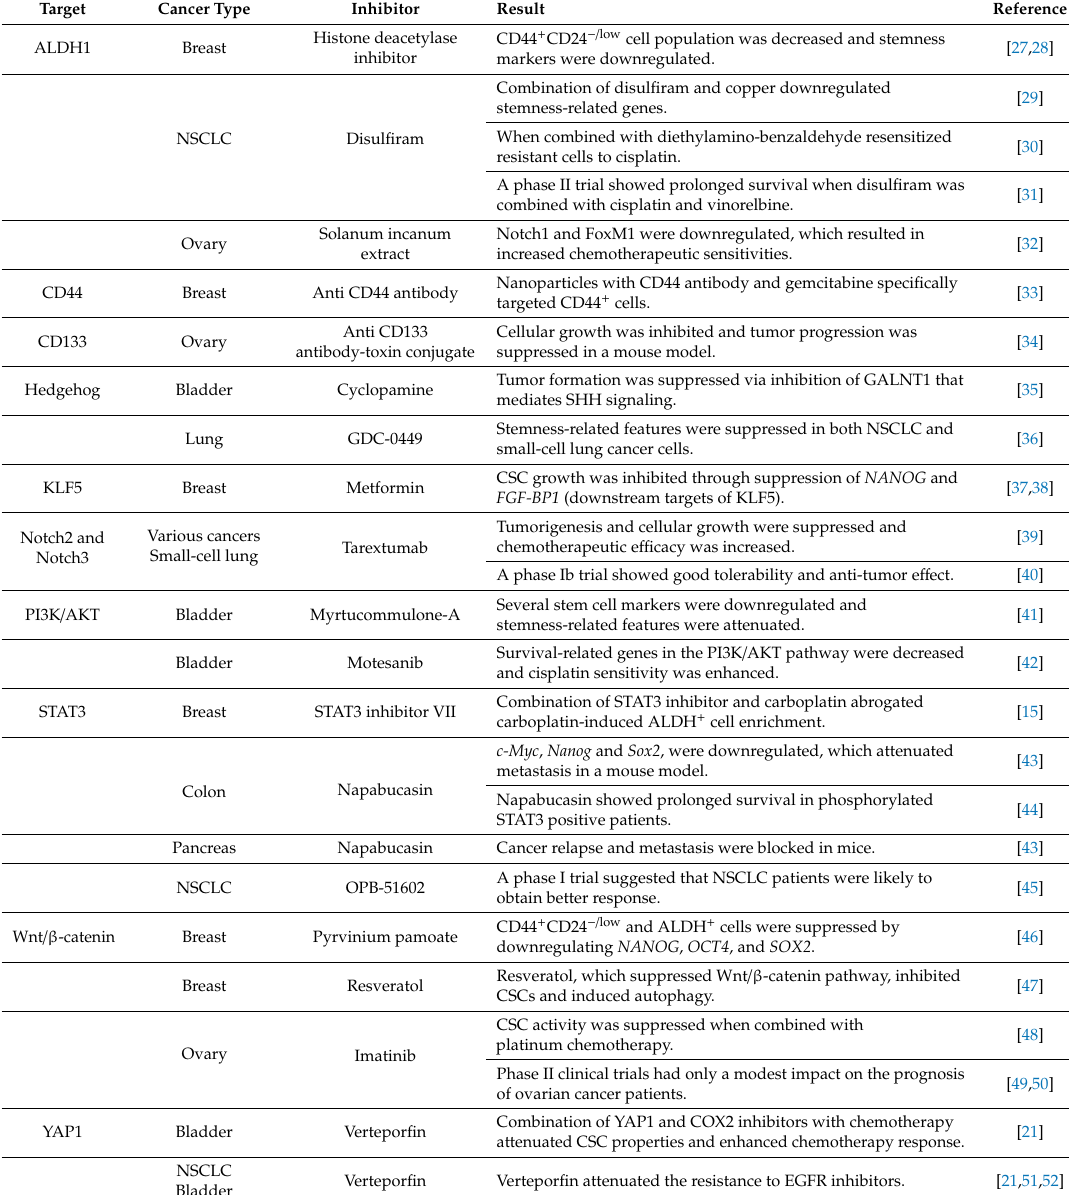
Table 1. Therapeutic attempts to target cancer stem cell